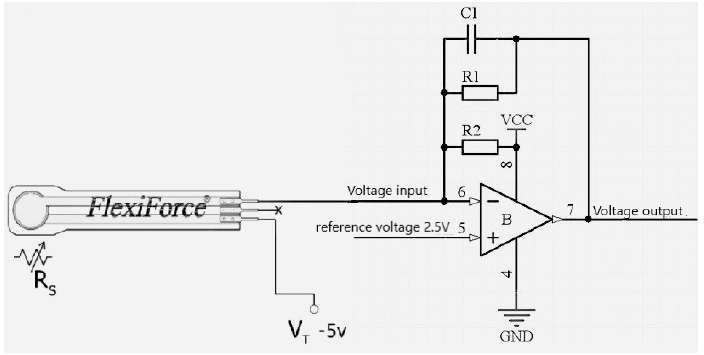
Figure 5. Data acquisition circuit.